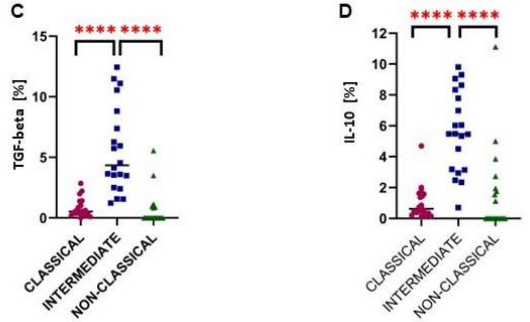
Figure 4. The comparison of the cytokine expression between classical, intermediate and non-classical monocytes. The pro-inflammatory molecules are noted in panels ( A , B ) (TNF and IL-12, respectively), whereas anti-inflammatory cytokines are distinguished in ( C , D ) graphs (TGF-beta and IL-10, respectively). * p < 0.05, ** p < 0.01, **** p < 0.0001. TNF, tumor necrosis factor; IL-12, interleukin 12; TGF-beta, transforming growth factor beta; IL-10, interleukin 10.